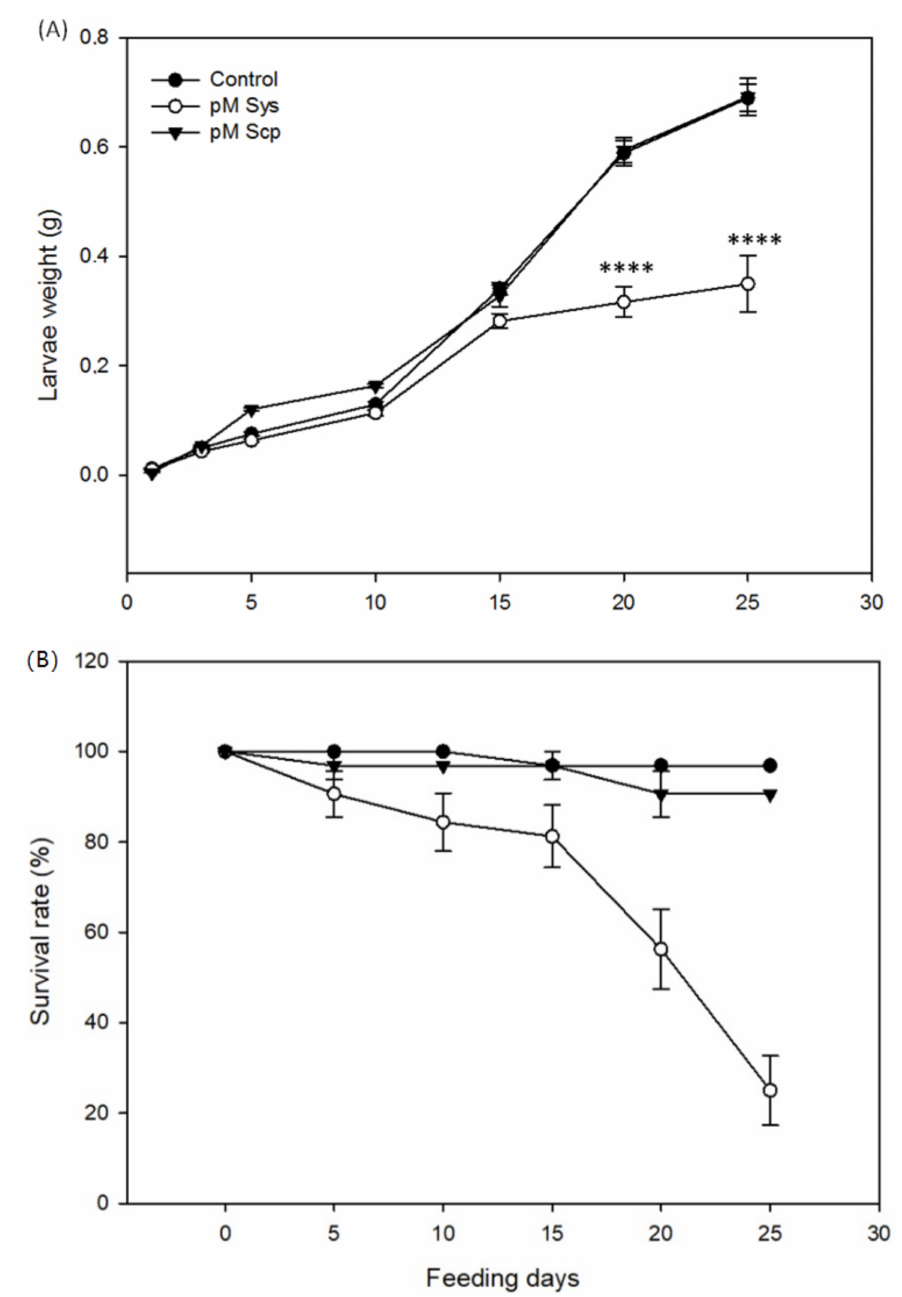
Figure 1. Systemin (Sys) foliar applications on S. littoralis larvae. ( A ) Mean weight ( ± S.E., standard error) of S. littoralis larvae feeding on control and treated leaves. ( B ) Survival rate of experimental S. littoralis larvae. Asterisks denote statistically significant di ff erences (one-way Analysis of Variance, ANOVA: **** p < 0.00001). A group of 32 larvae was used for each experimental condition and the experiment was repeated